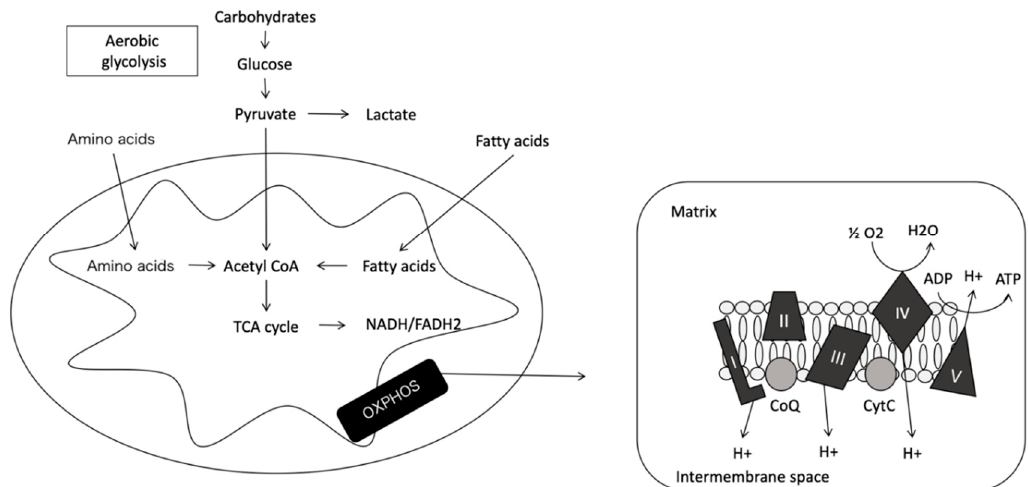
Figure 1. Simplified general summary of the main mitochondrial metabolic pathways. ADP, adenosine diphosphate; ATP, adenosine triphosphate; I, complex I; II, complex II; III, complex III; IV, complex IV; CoQ, coenzyme Q; CytC, cytochrome C; FADH, flavin and adenine dinucleotide; H+, proton; NADH, nicotinamide adenine dinucleotide hydrogen; OXPHOS, oxidative phosphorylation system; TCA, tricarboxylic acid and V, V complex.